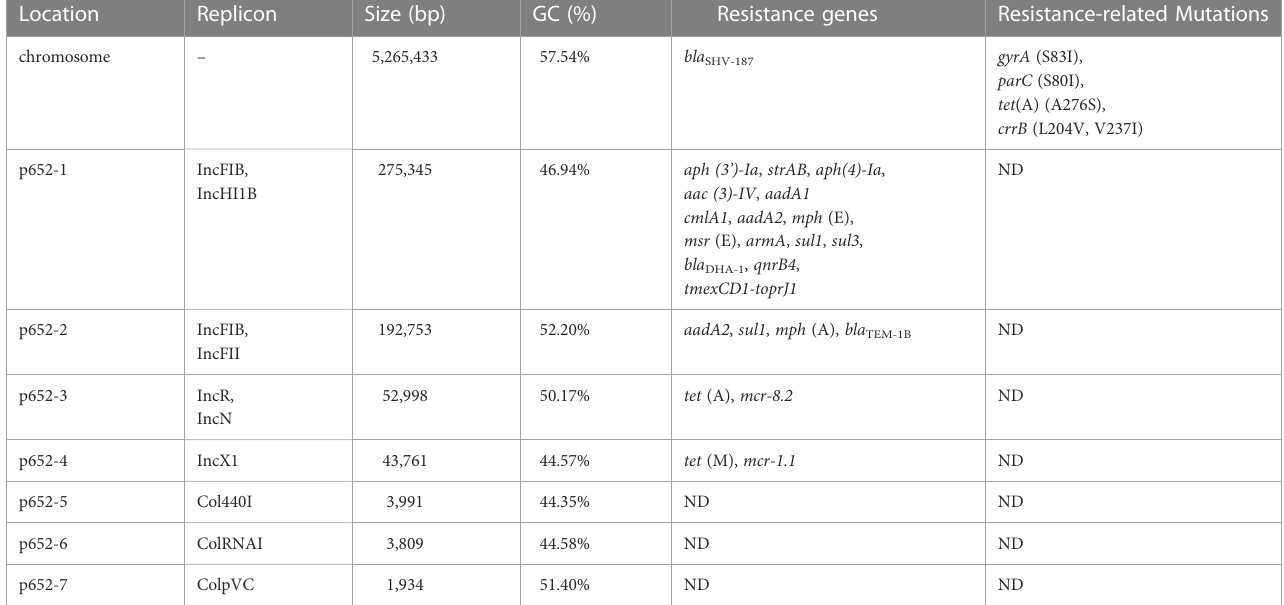
TABLE 1 Characteristics of KP15-652 genome